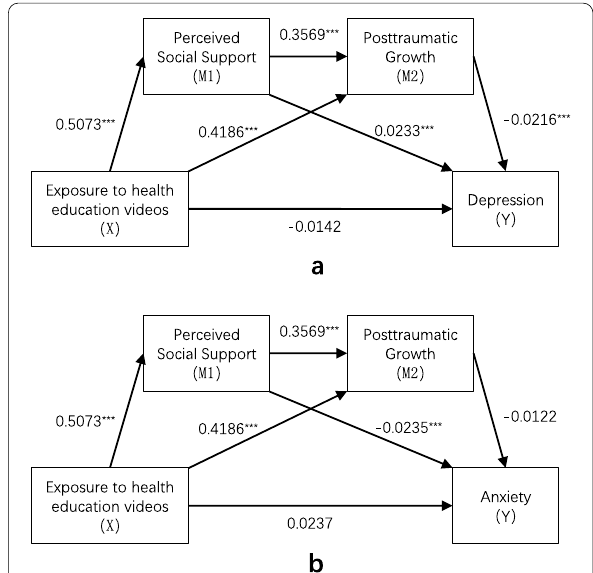
Fig. 1 Path diagram illustrating indirect effects and causal paths linking exposure to health education videos with mental health problems. ** p < 0.01; *** p < 0.001